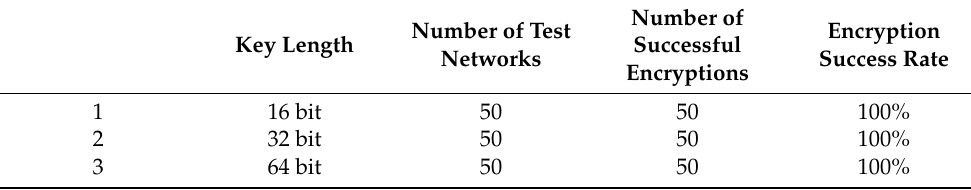
Table 1. Algorithm-security verification under different key lengths.